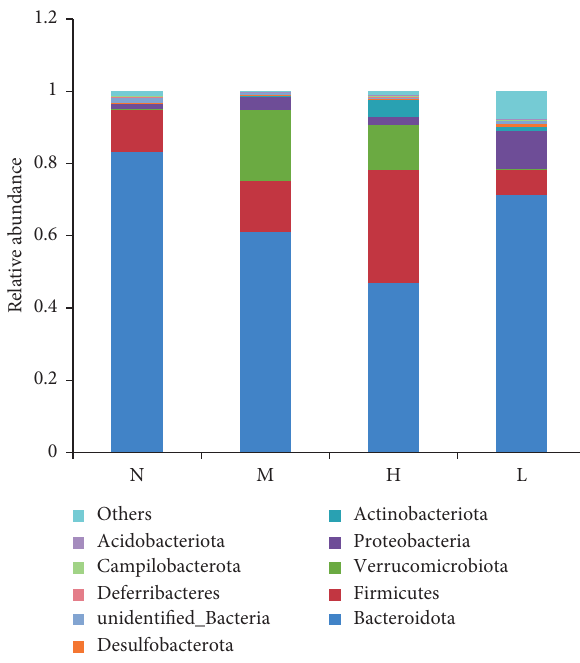
Figure 12: Relative abundance at the phylum